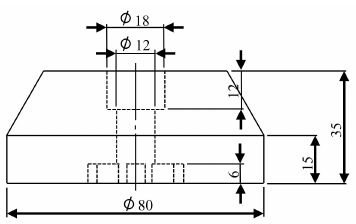
Figure 8. The conical workpiece for machining.